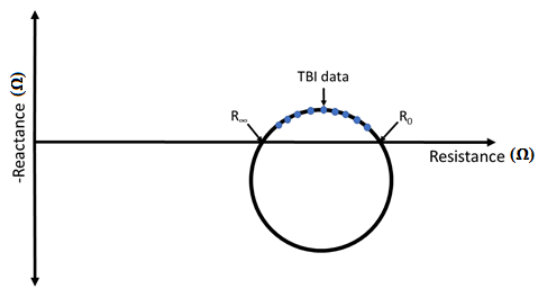
Figure 1. Illustrative example of Cole–Cole plot for Transthoracic Bioimpedance (TBI) measurements.